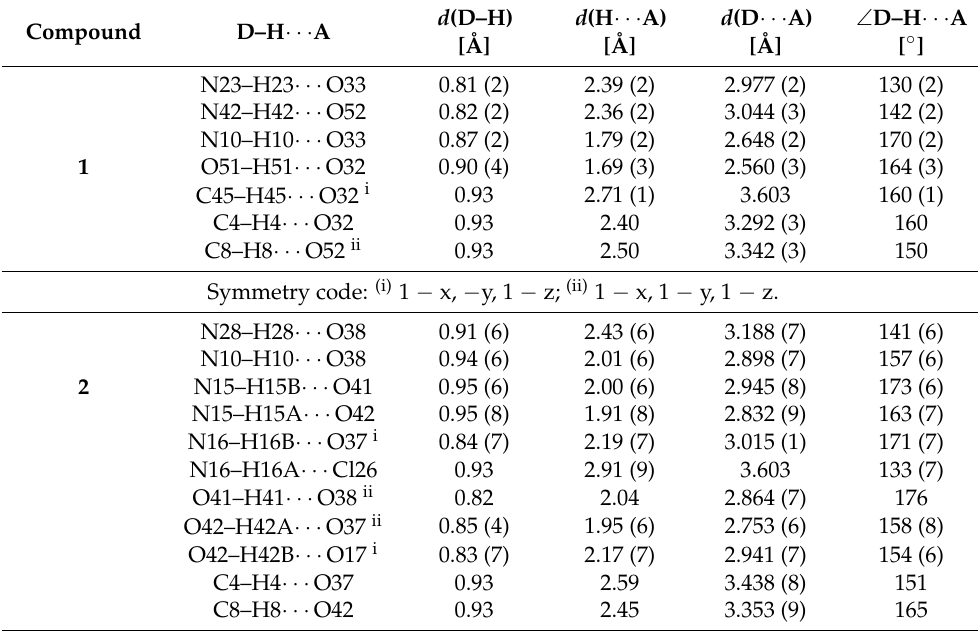
Figure 2. Heterotetramer formed by acridinium and diclofenac ions in compound 1 (hydrogen bonds are represented by dashed lines, whereas C–H · · · π interactions are represented by dotted lines). Table 2. Hydrogen bonds geometry for compounds 1 and 2